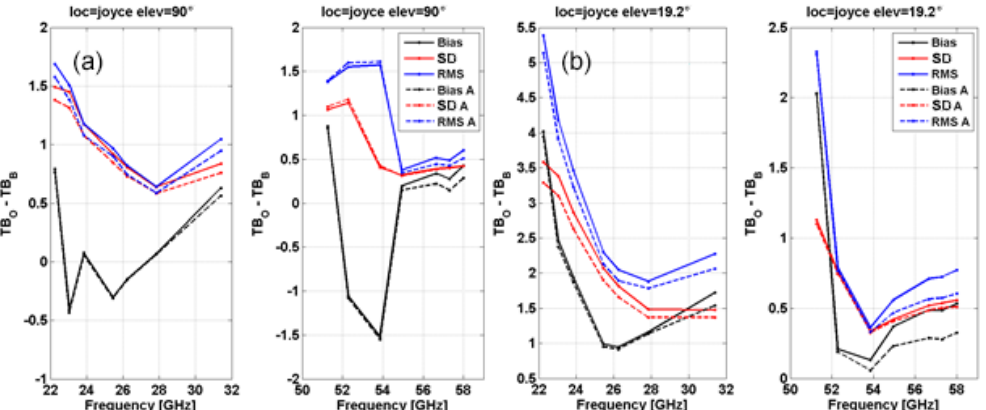
Figure 6. Statistics of the differences between TB observations and model background (solid lines) and between TB observations and model analysis (dashed lines). Simulated TB are computed with RTTOV-gb from AROME-France 3h forecast (solid lines) and AROME-France analyses (dashed lines) profiles in clear-sky conditions for Joyce at zenith. Panels (a) and (b) refer, respectively, to 90 and 19.2 ◦ elevation angle. Biases are shown with black lines, standard deviations with red lines, and RMS with blue